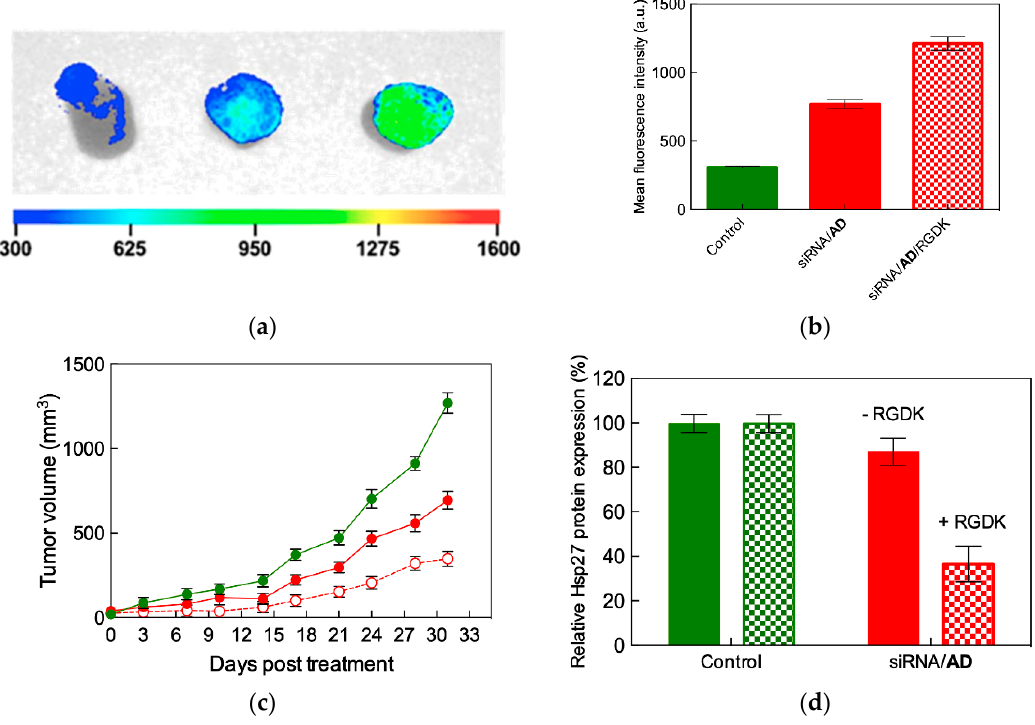
Figure 17. ( a ) Ex vivo fluorescence images obtained from tumor isolated from PC-3 xenograft mice treated with PBS buffer (delivery medium used as control, left), siRNA / AD (center), and siRNA / AD / E 16 G 6 RGDK nanoparticles (right). ( b ) Quantification of the mean fluorescence intensity for the images in panel a . PBS buffer ( c ) Tumor growth in untreated animals (green filled symbols), and in animals treated with siRNA / AD (red filled symbols). ( d ) In vivo knockdown of Hsp27 with siRNA / AD (-RGKD) and siRNA / AD / E 16 G 6 RGDK ( + RGDK) nanoparticles. Untreated animals were used as the control. The treatments (0.25 mg / kg siRNA, siRNA / AD N / P = 10, and AD / E 16 G 6 RGDK molar ratio = 5) were administered by intravenous injection twice per week. Adapted from [8] with permission of the American Chemical Society, 2018.